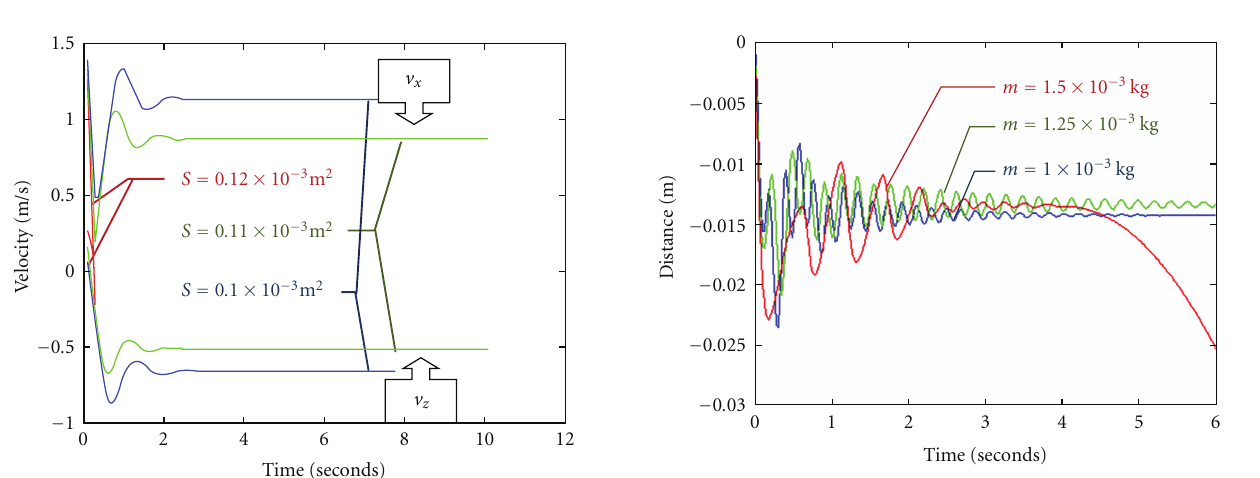
Figure 10: Dragonfly gliding down—changing the wing area. Velocity versus time.